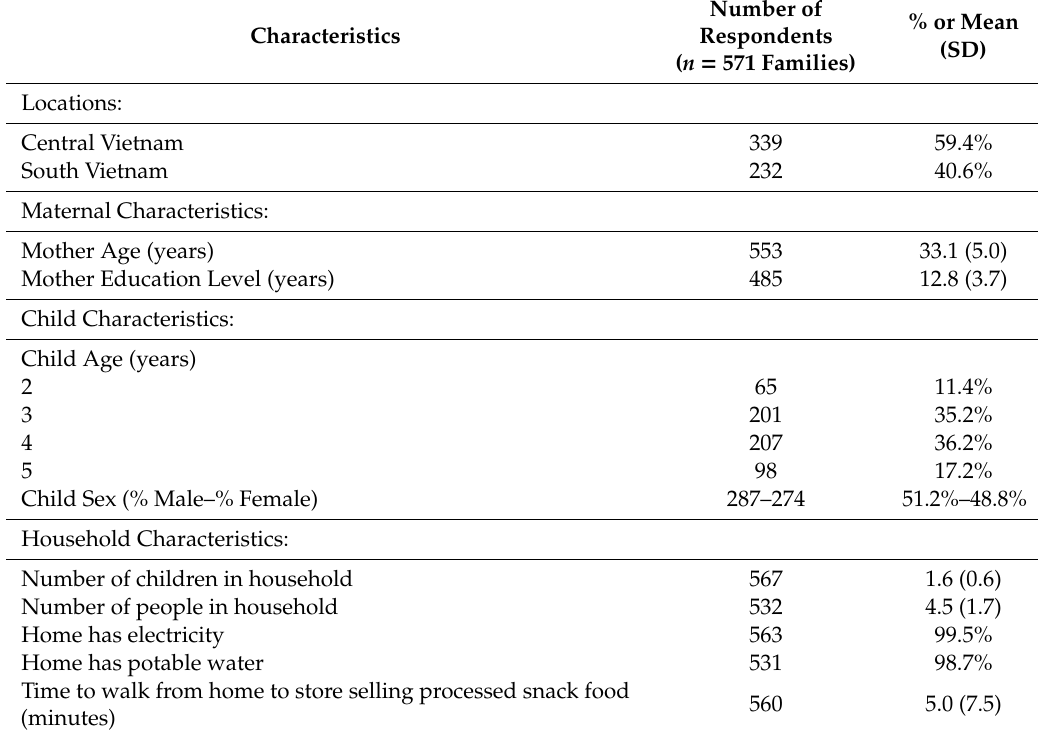
Table 1. Demographic characteristics of families, mothers and